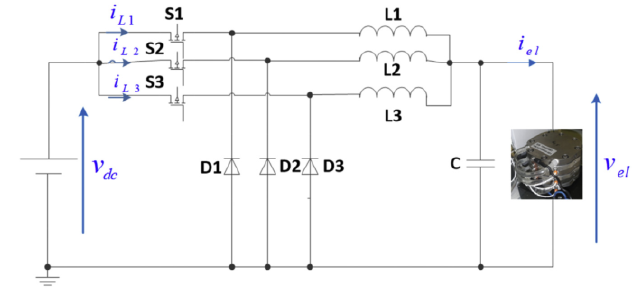
Fig. 3. IBC connected with the